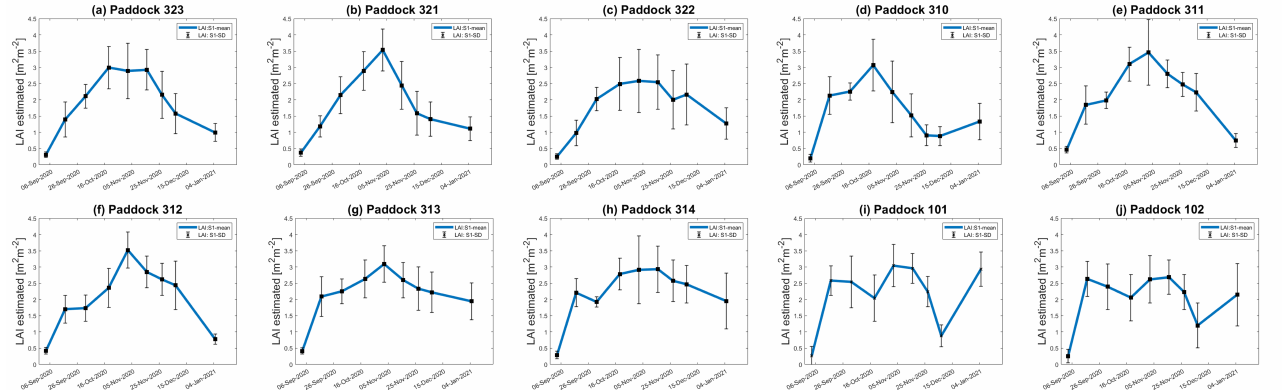
Figure 11. Seasonal evolution of LAI for all winter wheat paddocks in the BVCR study sites. The estimate uncertainty is represented as vertical bars. ( a ) Wheat paddock 323; ( b ) Wheat paddock 321; ( c ) Wheat paddock 322; ( d ) Wheat paddock 310; ( e ) Wheat paddock 311; ( f ) Wheat paddock 312; ( g ) Wheat paddock 313; ( h ) Wheat paddock 314; ( i ) Wheat paddock 101; ( j ) Wheat paddock